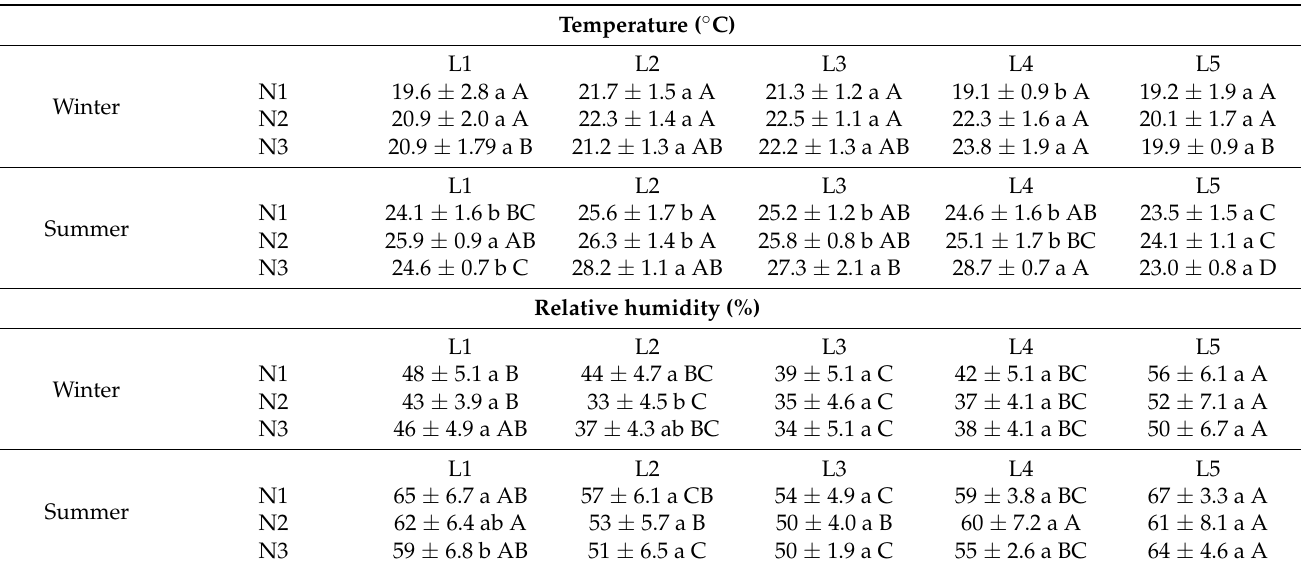
Table 2. Comparison between the mean daily temperature ( ◦ C) and relative humidity (%) obtained in the 43W aviary, in winter and summer, for the interaction between the level (N) and line (L) factors. Temperature ( ◦